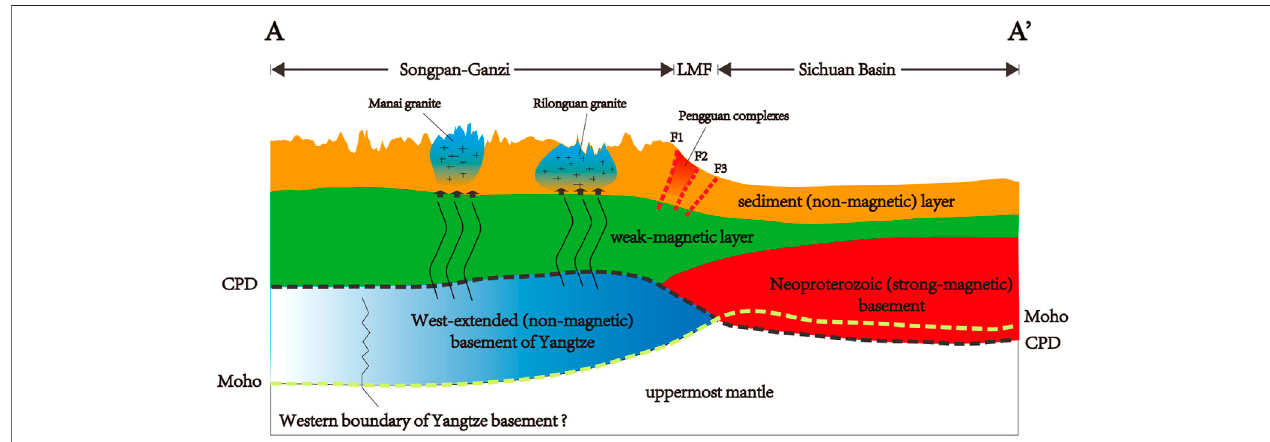
FIGURE 11 | Sketch of magnetic structure along the pro fi le AA ’ . Different colors represent different magnetic layers. Black and green dotted line marks the CPD and Moho boundary. F1: Wenchuan-Maoxian Fault, F2: Yingxiu-Beichuan Fault, F3: Shuangshi-Dachuan